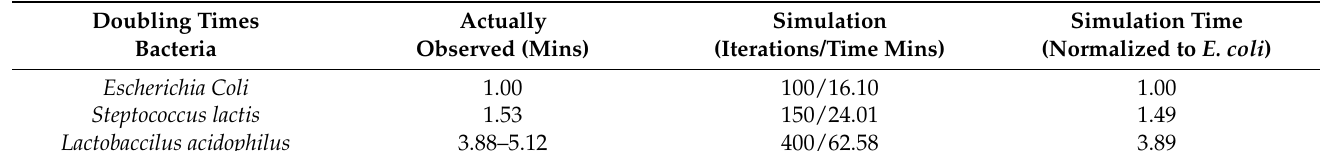
Table 2. Experimental average doubling times for bacterial cell growth over 100 runs of M bac with a limited amount of nutrients available. Doubling times have been normalized to E. coli times (columns 2 and 4) or estimated from the figures in Table 1 (column 3).